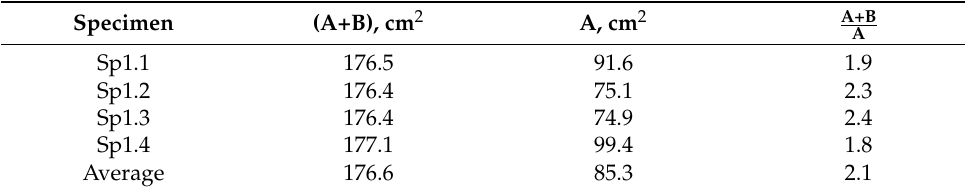
Table 6. Measured values of ( A + B ) and A and their ratio. Specimen